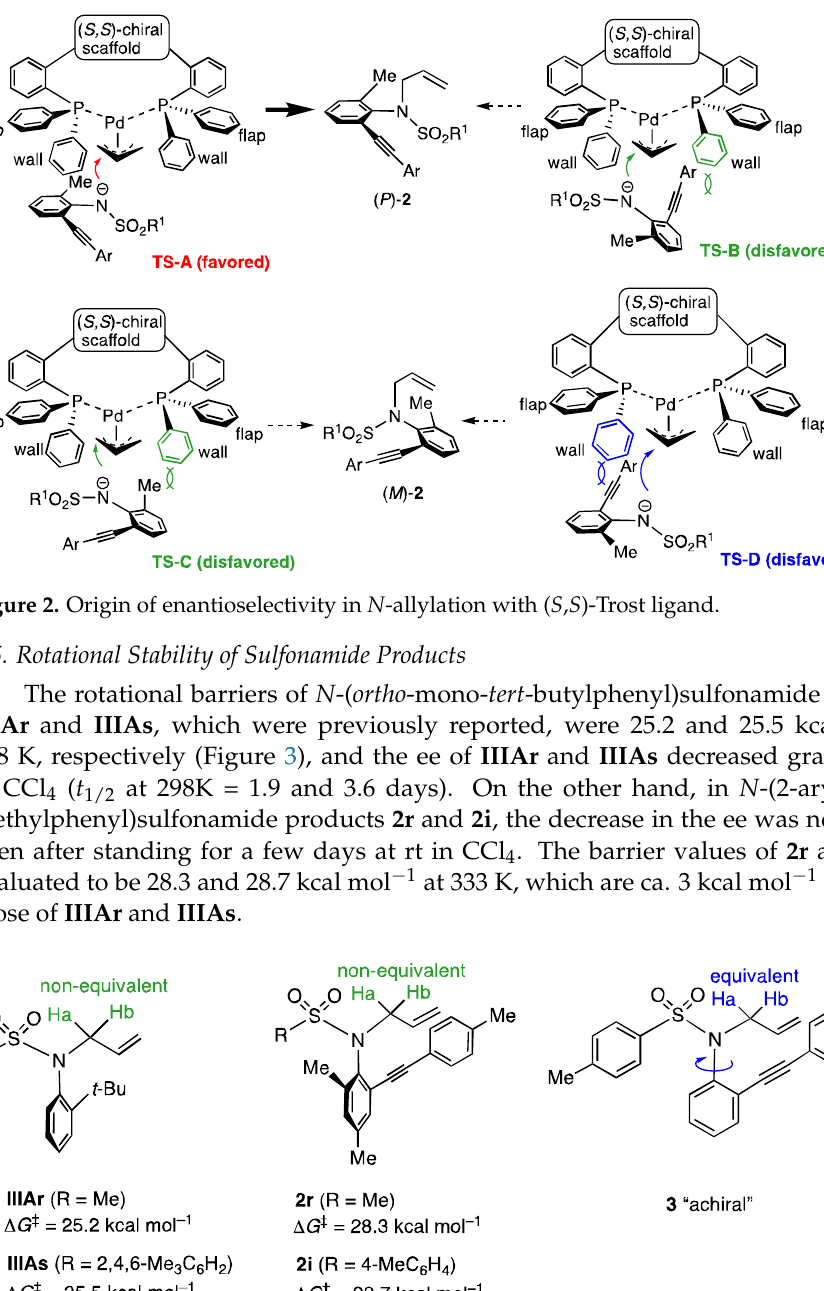
Figure 3. Rotational stability of several sulfonamides bearing ortho -substituents.